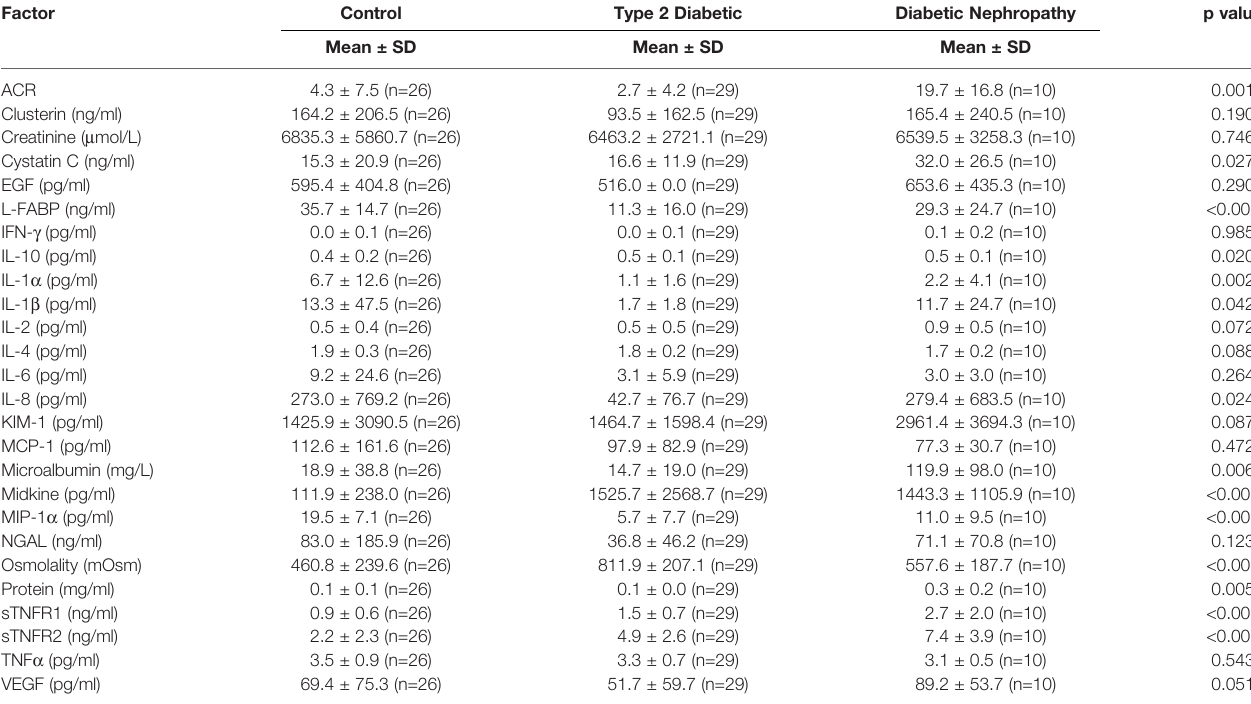
TABLE 3 | Urine biomarkers (mean ± SD). Factor